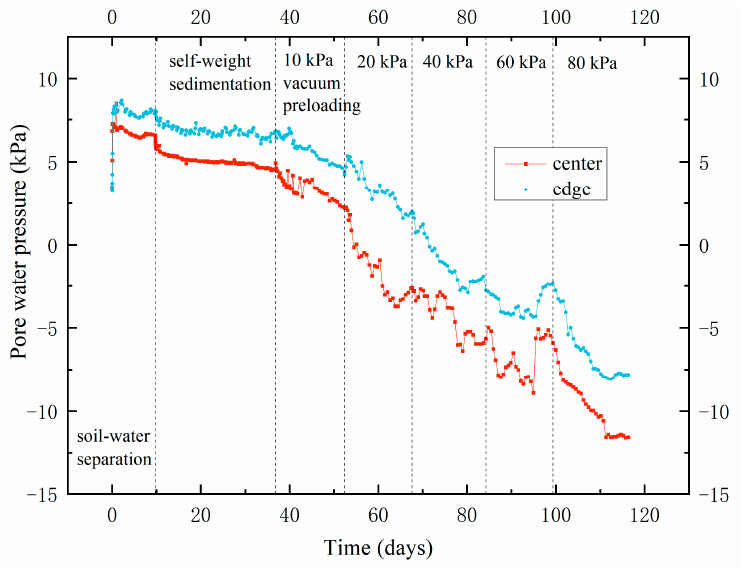
Figure 9. Time-dependent pore water pressure curves in the different stages of treatment.